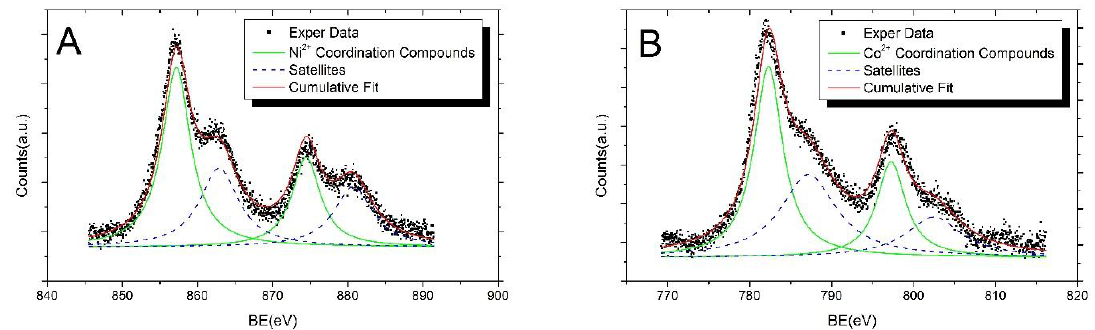
Figure 5. Ni2p and Co2p core levels spectra of thiol-functionalized AgNPs with 1.0 ppm of nickel (panel A ) and 1.0 ppm of cobalt (panel B ). Table 4. HR-XPS Ni2p 3/2 and Co2p 3/2 metal core levels data collected on silver NPs stabilized by 3MPS in presence of nickel and cobalt ions (BE, FWHM, and assignments).